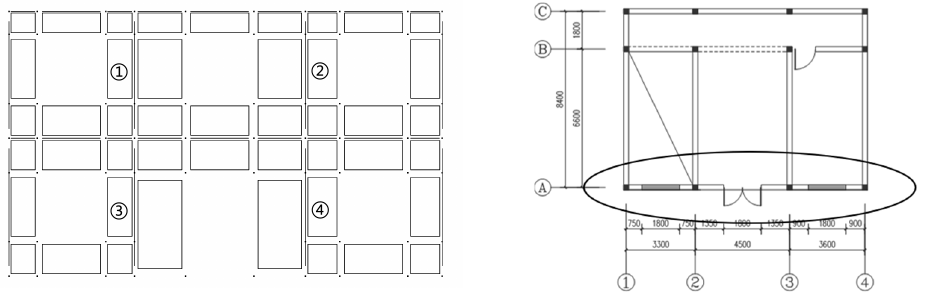
Figure 13. Elevation of masonry wall elements at the A ‐ axis.